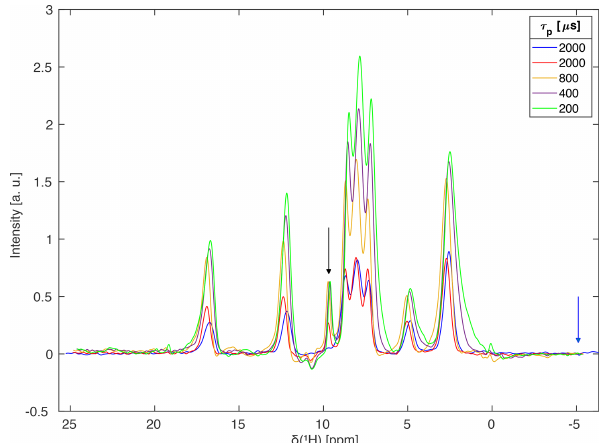
Figure 8. Homonuclear-decoupled proton spectra of L-histidine using FSLG decoupling and different selectivity of the I-BURP-2 pulse in the spin-lock frame at 14kHz MAS. The spectra were ac- quired at a proton resonance frequency of 600MHz using a Bruker 2.5mm probe which has a much stronger rf-field inhomogeneity than the 1.9mm MAS probe used in Fig. 7. The carrier was placed in the centre of the region of interest (arrow indicating the exact po- sition) for all spectra except the blue one. One can clearly see that longer (more selective) pulses reduce the intensity of the signal but lead to narrower lines, especially on the side of the peak pointing away from the carrier frequency. There is a small carrier-frequency artefact for the spectra with the carrier frequency inside the spec- tral region of interest. Experimental scaling factors were 0.572 for the 2ms I-BURP-2 pulses, 0.575 for the 800µs pulse, and 0.579 for the 400 and 200µs pulses. The modulation frequency was set to 100kHz for the 2ms and 800µs, 95kHz for the 400µs, and 90kHz for the 200µs I-BURP-2 pulses. The modulation frequencies were selected such that the bandwidths of the different pulses cover the region of maximum intensity in the nutation